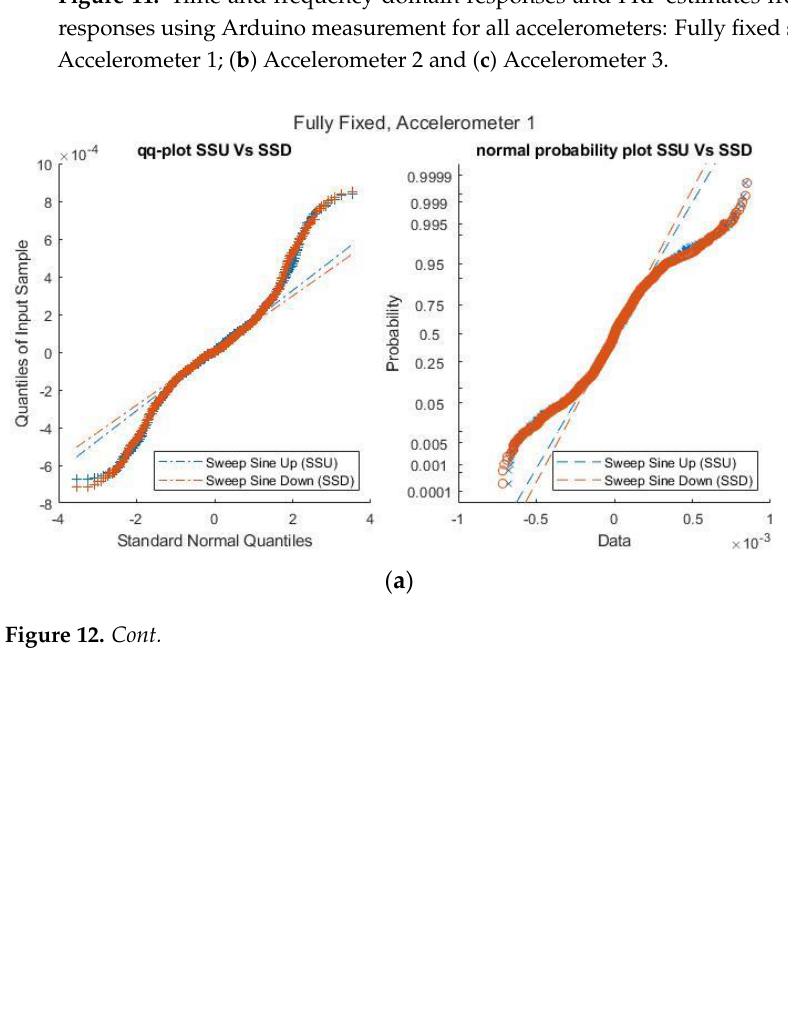
Figure 11. Time and frequency domain responses and FRF estimates from swept sine responses using Arduino measure- ment for all accelerometers: Fully fixed scenario for ( a ) Accelerometer 1; ( b ) Accelerometer 2 and ( c ) Accelerometer 3.